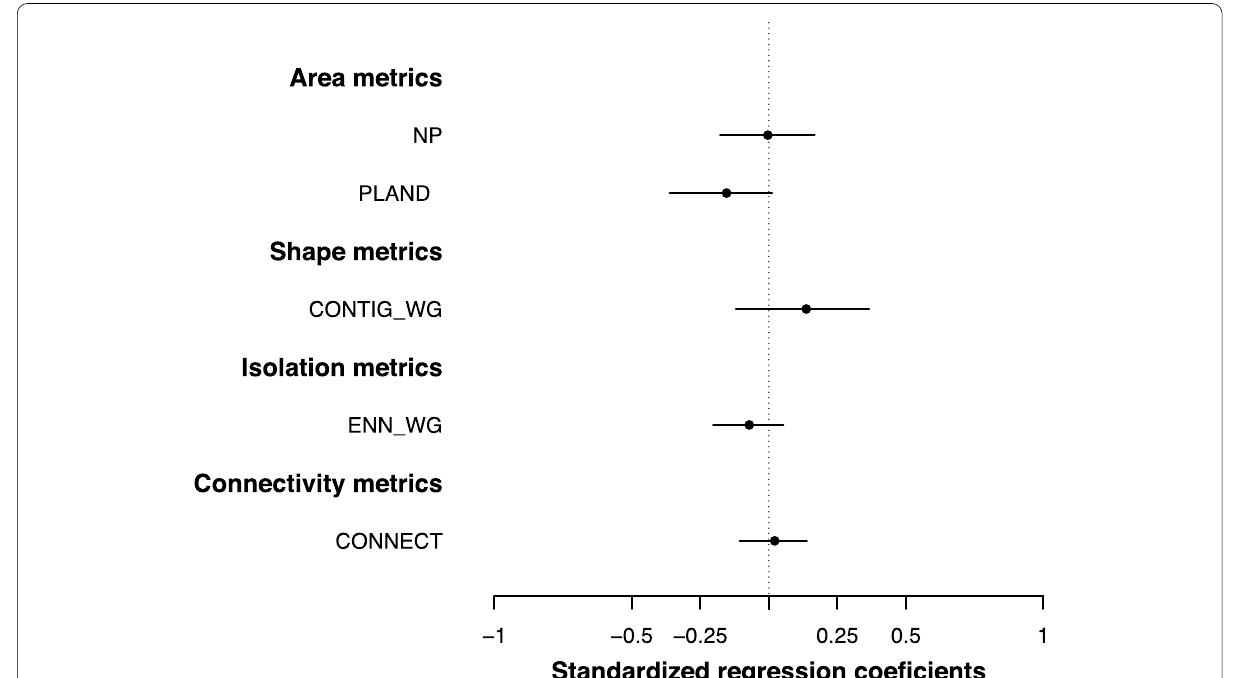
Fig. 1 Confidence intervals of the standardized regression coefficients of the BLMM model relating landscape metrics and Dromiciops gliroides occurrence. The effects of landscape metrics are considered significant when their confidence intervals do not overlap the zero